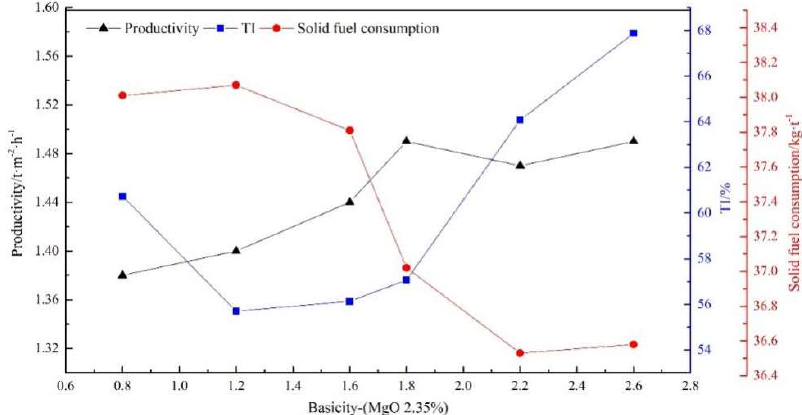
Figure 4. Effect of basicity on sintering performance with 2.35% MgO content.